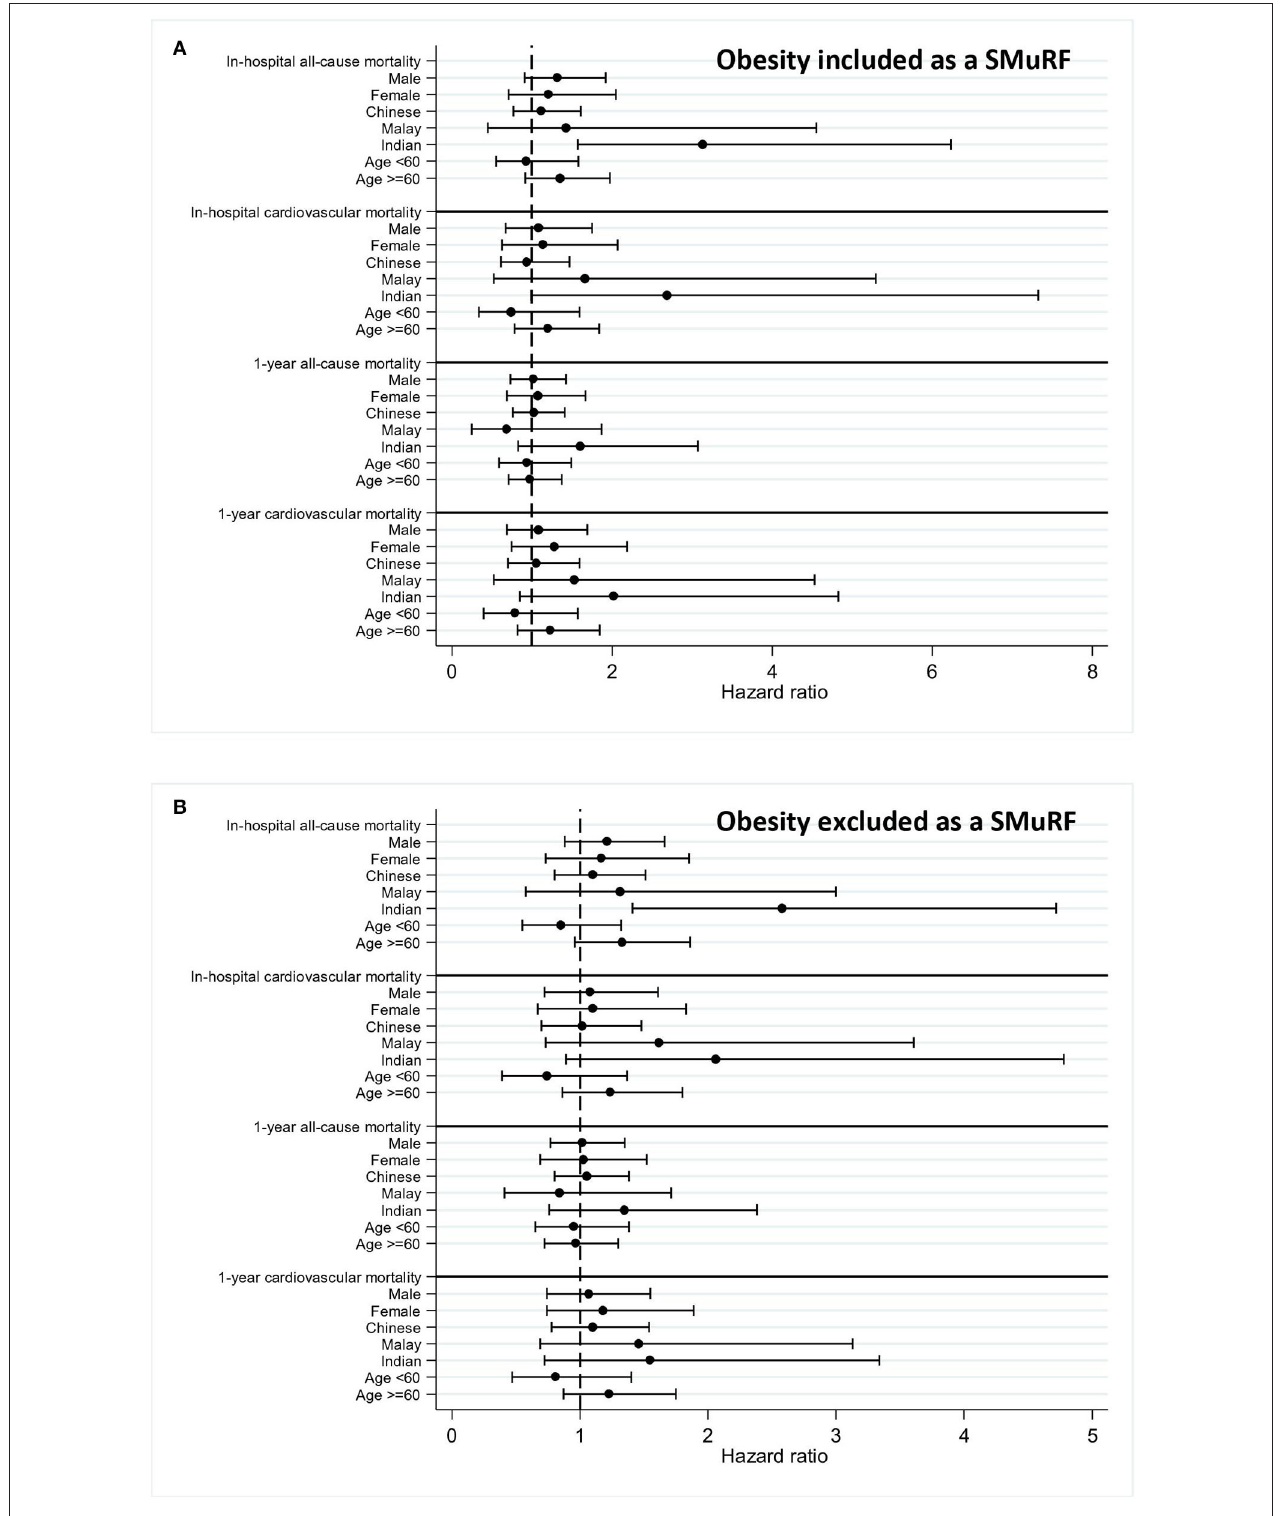
FIGURE 3 | Forest plot for an adjusted hazard ratio of mortality within subgroups. Adjusted hazard ratios of mortalities within subgroups (men, women, Chinese, Malay, South Asian, and age) were calculated and plotted in forest plots for patients with myocardial infarction (MI) with 95% confidence intervals (CI). Obesity was included (A) or excluded (B) as a SMuRF for the